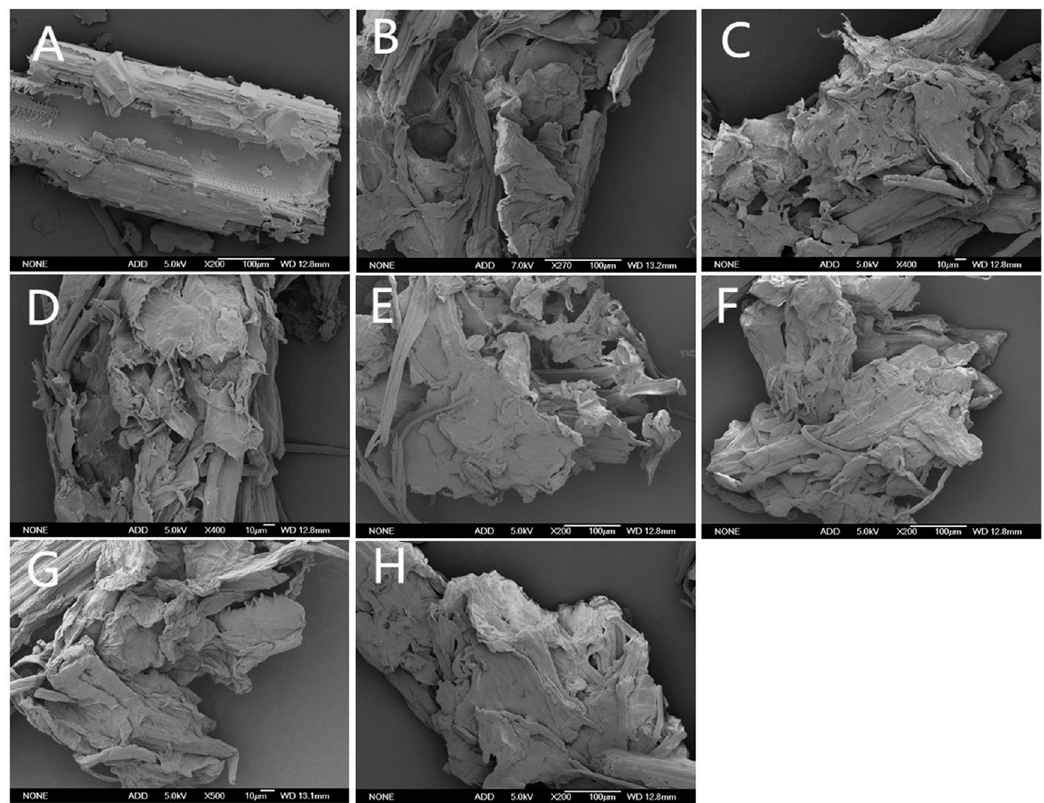
Figure 4. SEM of remaining straw after untreated and alkaline black liquor circulation with di ff erent times combined with ozone treatment. ( A ) untreated; ( B ) straw of alkaline black liquor cycle 0 times combined with ozone treated; ( C ) straw of alkaline black liquor cycle 1 time combined with ozone treated; ( D ) straw of alkaline black liquor cycle 2 times combined with ozone treated; ( E ) straw of alkaline black liquor cycle 3 times combined with ozone treated; ( F ) straw of alkaline black liquor cycle 4 times combined with ozone treated; ( G ) straw of alkaline black liquor cycle 5 times combined with ozone treated; ( H ) straw of alkaline black liquor cycle 6 times combined with ozone treated.